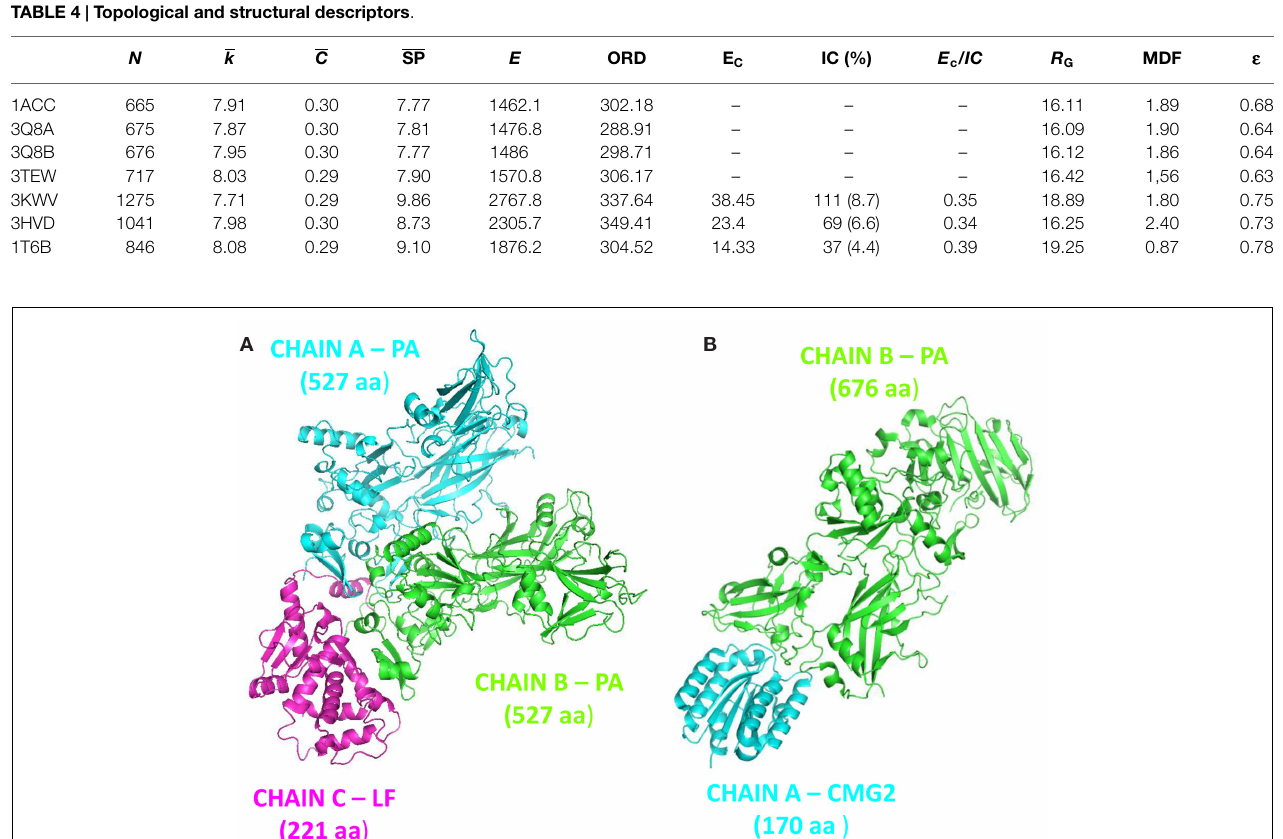
FIGURE 1 | Complex structures: (A) PA–PA–LF trimeric complex (PDB: 3KWV); (B) dimeric complex PA–CMG2 (PDB: 1T6B) .